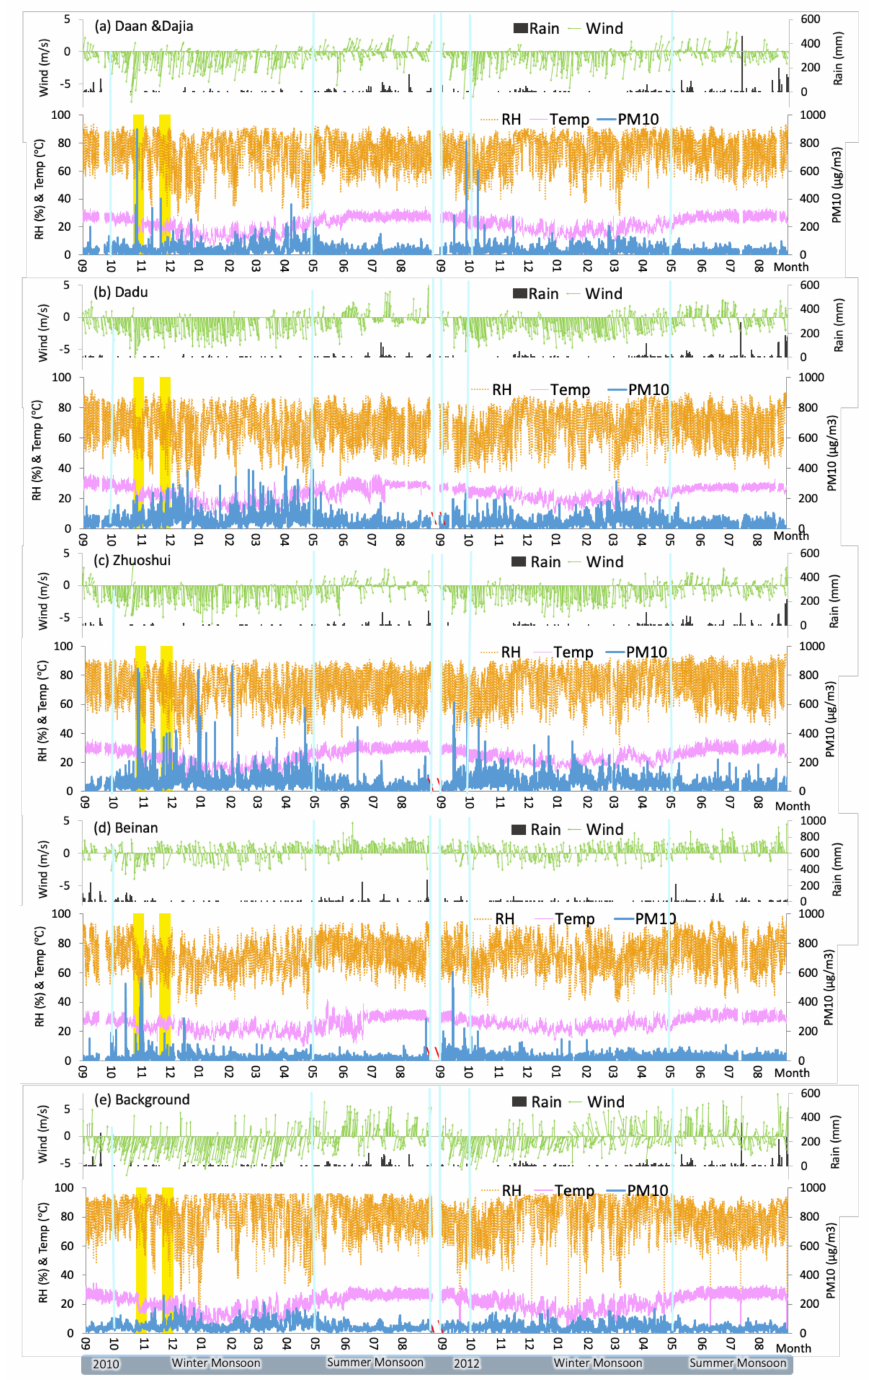
Figure 2. Wind speed and direction, relative humidity (orange line), temperature (pink line), and PM 10 concentration observed at the ( a ) Daan and Dajia, ( b ) Dadu, ( c ) Zhuoshui, and ( d ) Beinan riverbed monitoring stations, and rainfall amounts observed at the closest general EPA stations adjacent to the rivers from 1 September 2010 to 31 August 2011, and 1 September 2012 to 31 August 2013. Observations from ( e ) Sanyi background station are plotted for comparison. Two selected events for discussion are marked with yellow